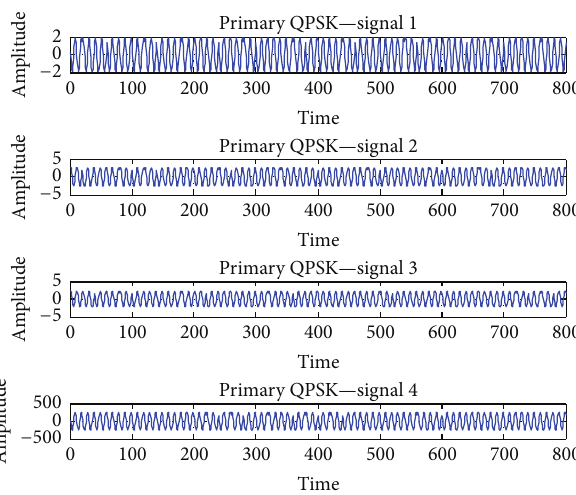
Figure 8: Source signals waves. Signal 1 to signal 3 are mixed weak object signal waveforms. Signal 4 is the strong interference signal waveform.